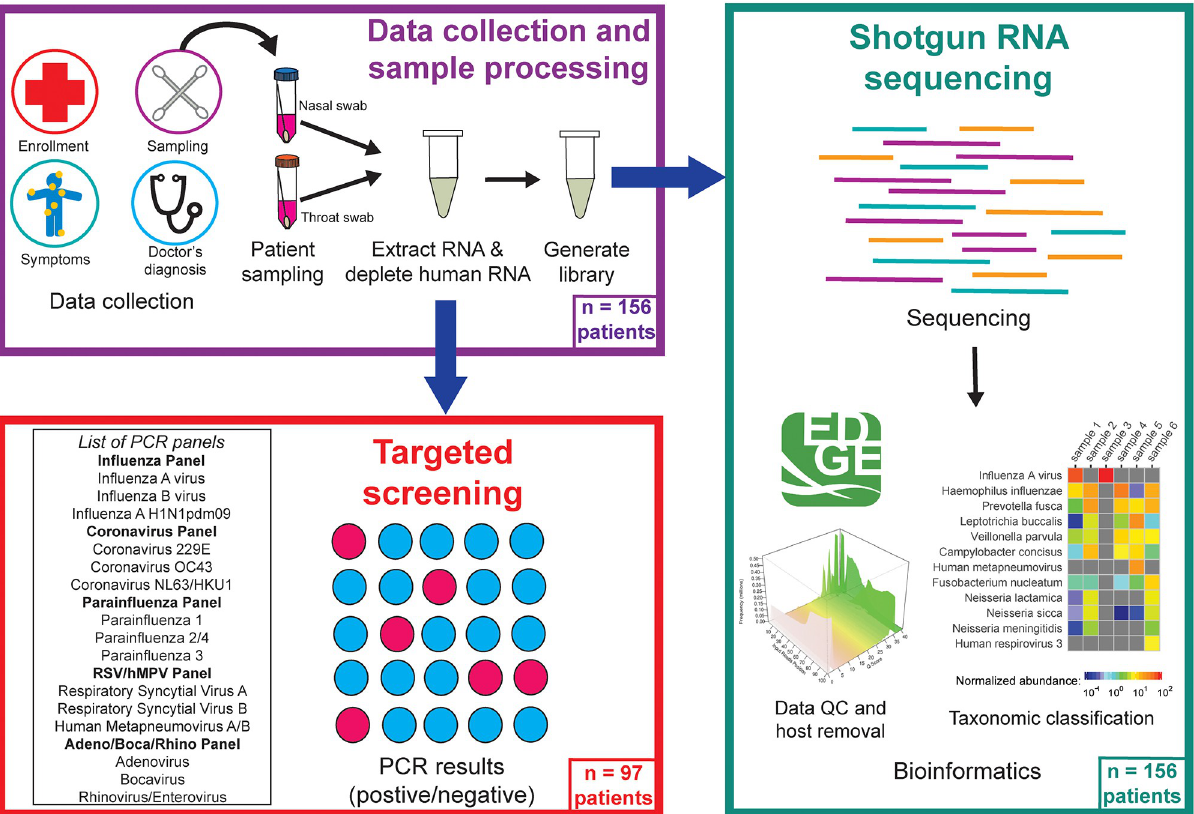
Fig 1. Sample collection and data processing. Individuals at the clinic were enrolled in the study and self-reported their symptoms. Nasal and throat swabs were then collected from individuals, from which RNA was extracted and human RNA was depleted. Extracted RNA was used in the PCR panels (97 individuals), while libraries were created for samples from all individuals and sequenced using an Illumina NextSeq. The shotgun RNA sequencing reads were analyzed using EDGE Bioinformatics and various taxonomic tools implemented within